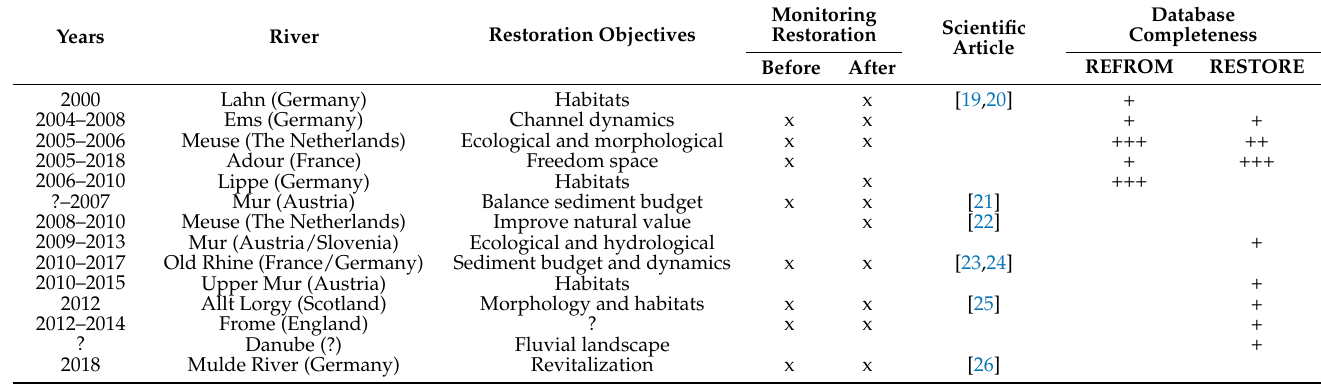
Table 1. List of restoration projects in which bank protection removal measures were applied. This database was compiled from existing scientific publications and restoration projects listed within two freely accessible European restoration project databases REFORM “https://wiki.reformrivers.eu (accessed on 15 February 2023)” and RESTORE “https://restorerivers.eu (accessed on 15 February 2023)”. Degree of database completeness: (+) = very little information; (++) = mi-correctly filled in; (+++) =